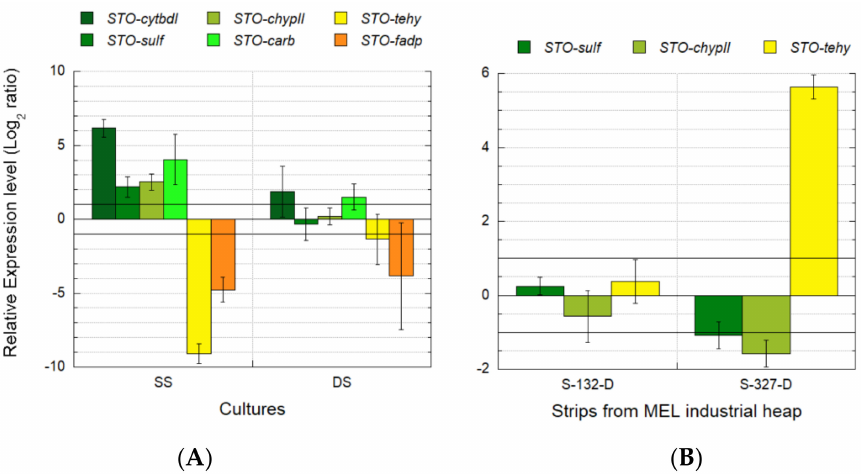
Figure 12. Transcriptional dynamics of cytbdI , sulf , chypII , carb , tehy , and fadp genes from Sulfobacillus sp. CBAR13 (STO) growing in a pure culture test with different electron donors (SS with Fe 2+ and DS with tetrathionate) ( A ), and industrial bioleaching strips from the MEL-heap with different availabilities of Fe 2+ (0.24 and 0.04 g L − 1 Fe 2+ in S-132-D and S-327-D, respectively) ( B ). Significant differences in relative expression were adjusted at − 1 < Log 2 ratio < 1 (horizontal black lines). Gene expression was calculated relative to a control sample (log 0 values) that correspond in ( A , B ), respectively, to one biological triplicate from DS cultures and one technical triplicate from S-132. Vertical bars in each column correspond to the standard deviation (SD) calculated with biological and technical